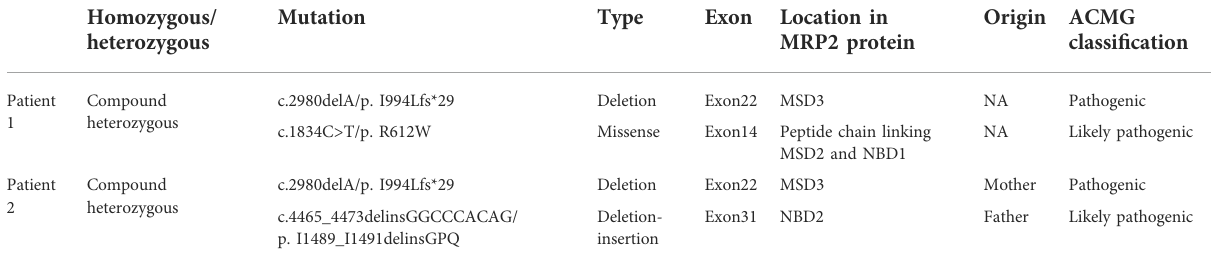
TABLE 2 Variants of ABCC2 in the patients with Dubin – Johnson